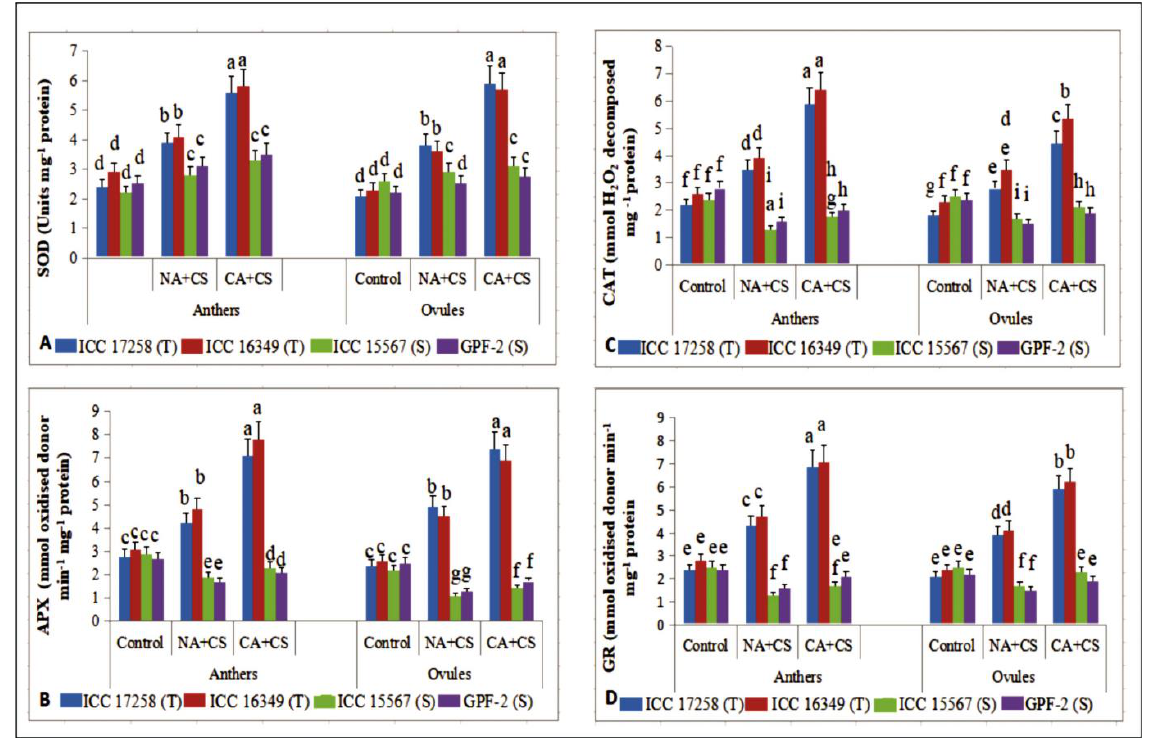
Figure 7. Superoxide dismutase (SOD; ( A )), ascrobate peroxidase (APX; ( B )), catalase (CAT; ( C )) and glutathione reductase (GR; ( D )) in anthers and ovules of control, non-acclimated, cold stressed; NA + CS) and cold-acclimated, cold stressed (CA + CS) plants of tolerant (T) and sensitive (S) genotypes. Small vertical bars represent standard errors (Mean ± S. E; n = 3). Different small letters on vertical bars indicate significant differences from each other ( p < 0.05; Tukey’s test). Least significant difference (LSD) for interaction ( p < 0.05) (genotypes × treatments): SOD (0.54), CAT (0.62), APX (0.45), GR (0.49).